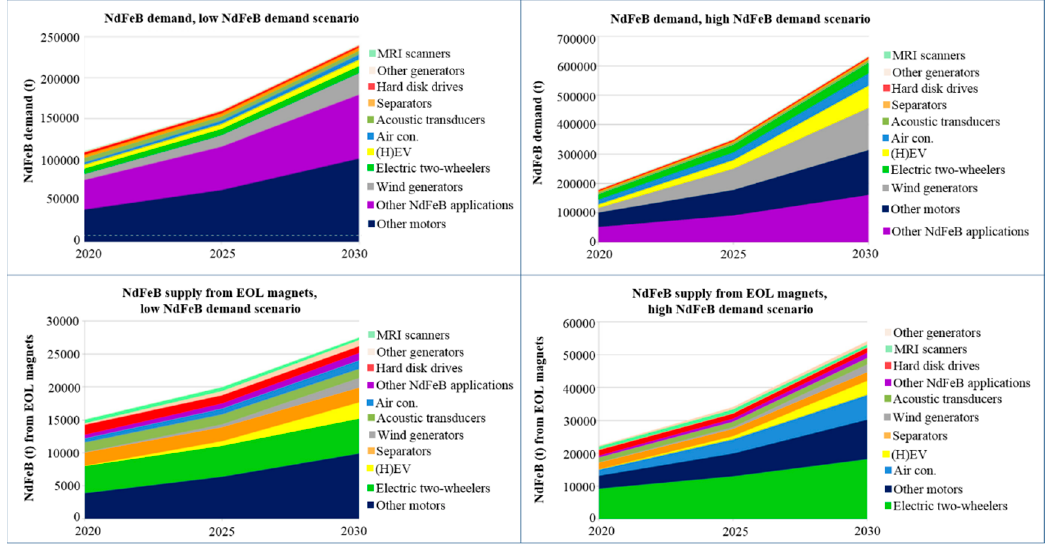
Figure 4. NdFeB demand and net supply from End-of-Life (EOL) magnets (losses during collection and disassembly have been subtracted) [41]; published by Elsevier, 2016.